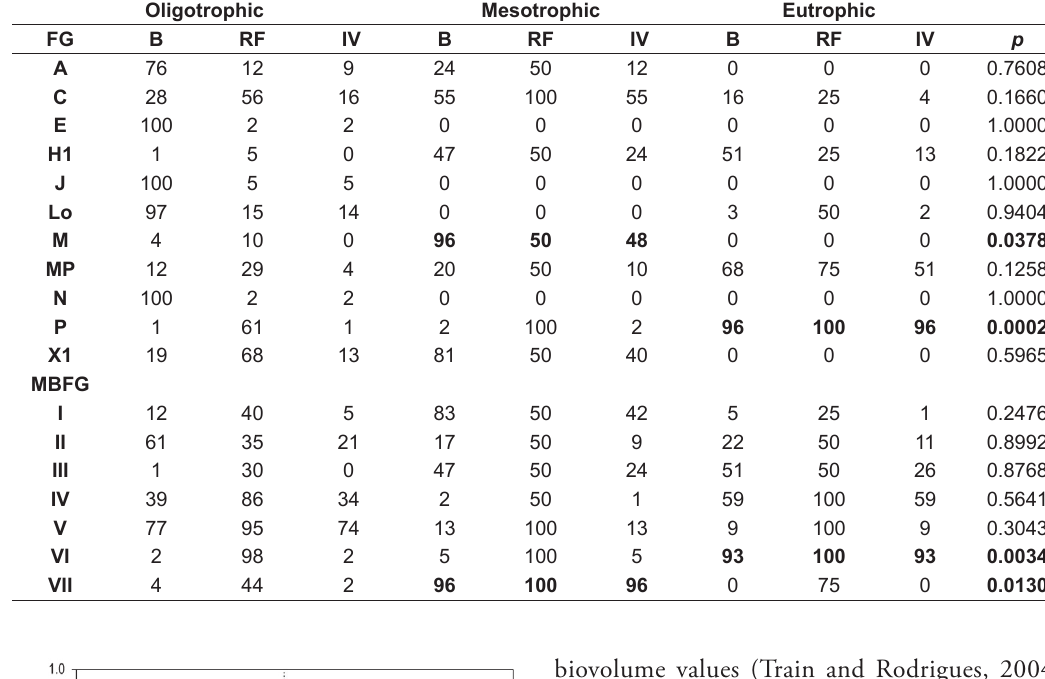
Table 2. The FGs and MBFGs indicative of trophic status (B-biovolume (mm 3 L –1 ); RF-Relative frequency; Indicator Value-IV). Significant values (p<0.05), high indicator values and high values of B and FR are highlighted in bold.